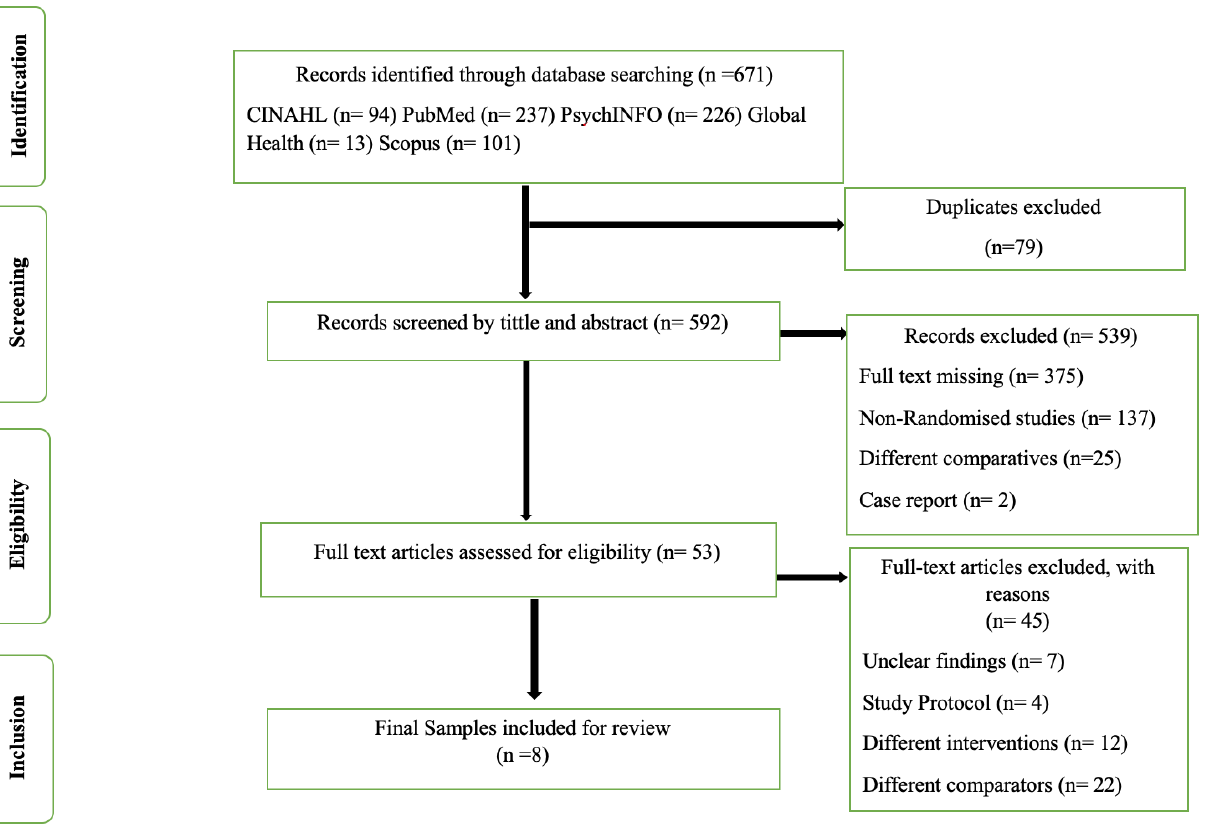
Figure 1. PRISMA flow diagram of the identification, screening, eligibility, and inclusion processes for studies.